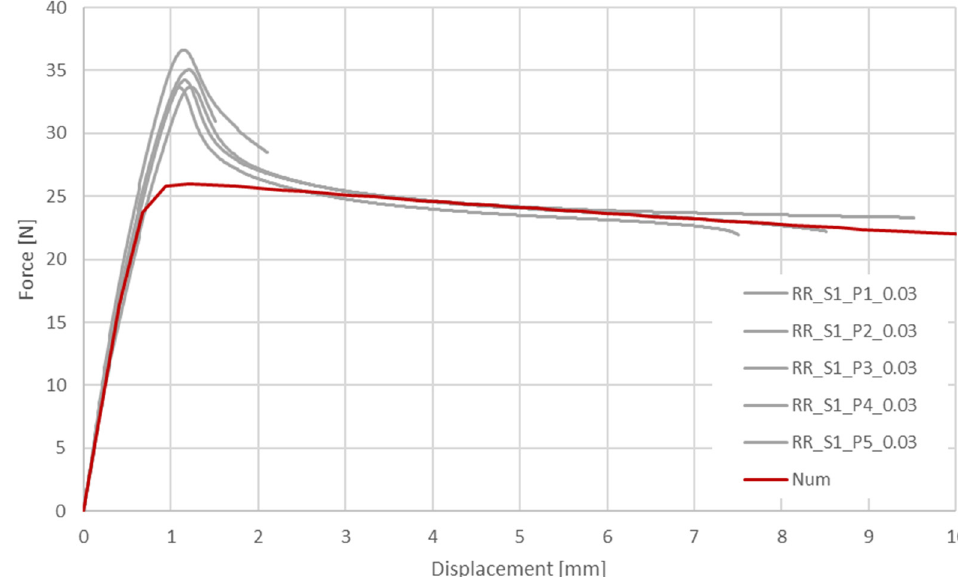
Figure 10. Comparison of the experimental and corresponding numerical results of tension forces during longitudinal tensile tests of tubes made of PLGA bioresorbable polymer: variant 2:72.0 mm/min.